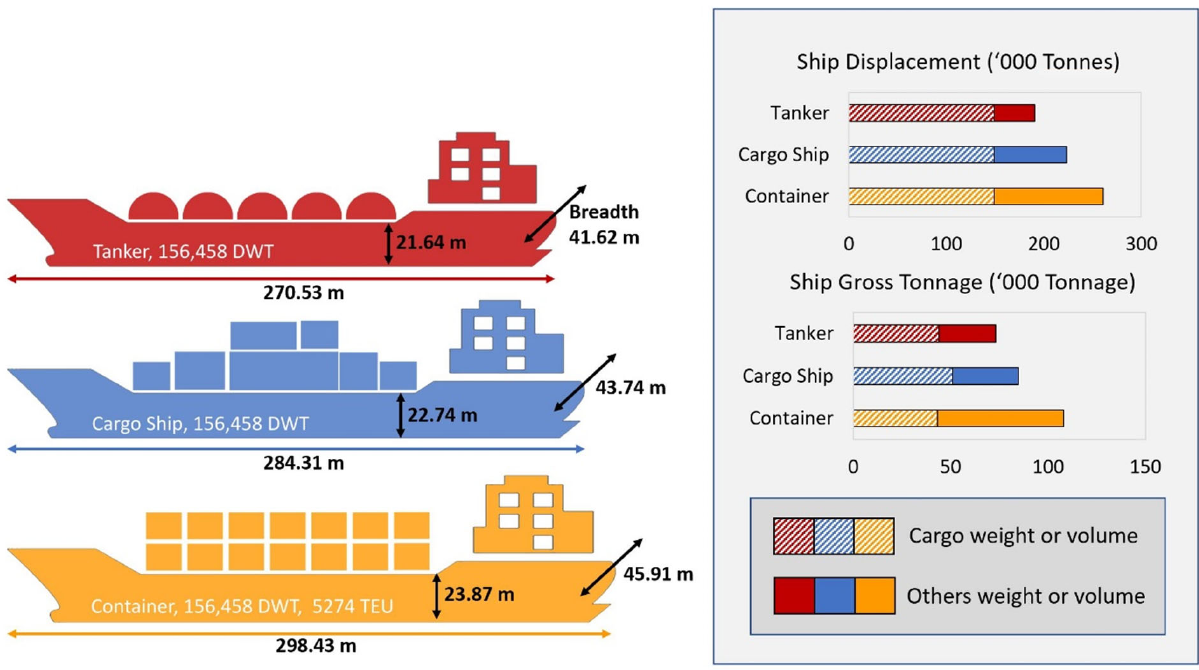
Figure 3. Comparison of the dimension, displacement, and gross tonnage of containership, cargo ship, and tanker with same design deadweight.